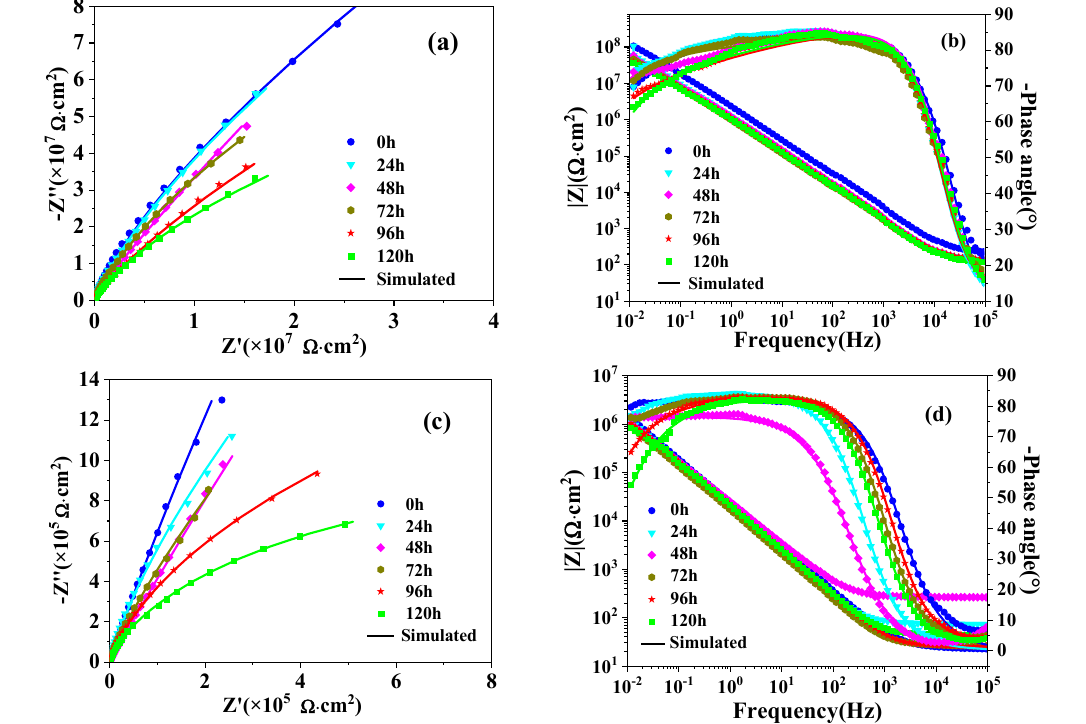
Figure 6. Nyquist and Bode plots of impedance spectra acquired from two specimens immersing in Ringer’s solution at 37 °C for five days at the corresponding E OCP . Niobium coating: ( a ) Nyquist plot, ( b ) Bode plot; Ti–6Al–4V substrate: ( c ) Nyquist plot, ( d ) Bode plot.